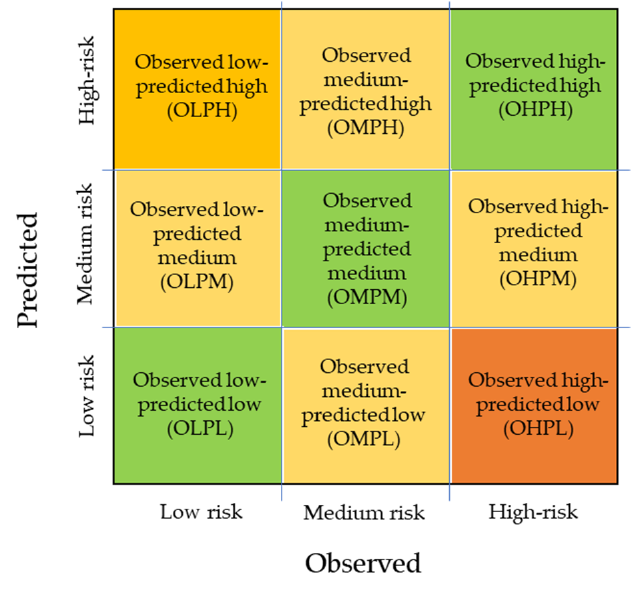
Figure 5. Representation of possible outcomes of the fitted model.